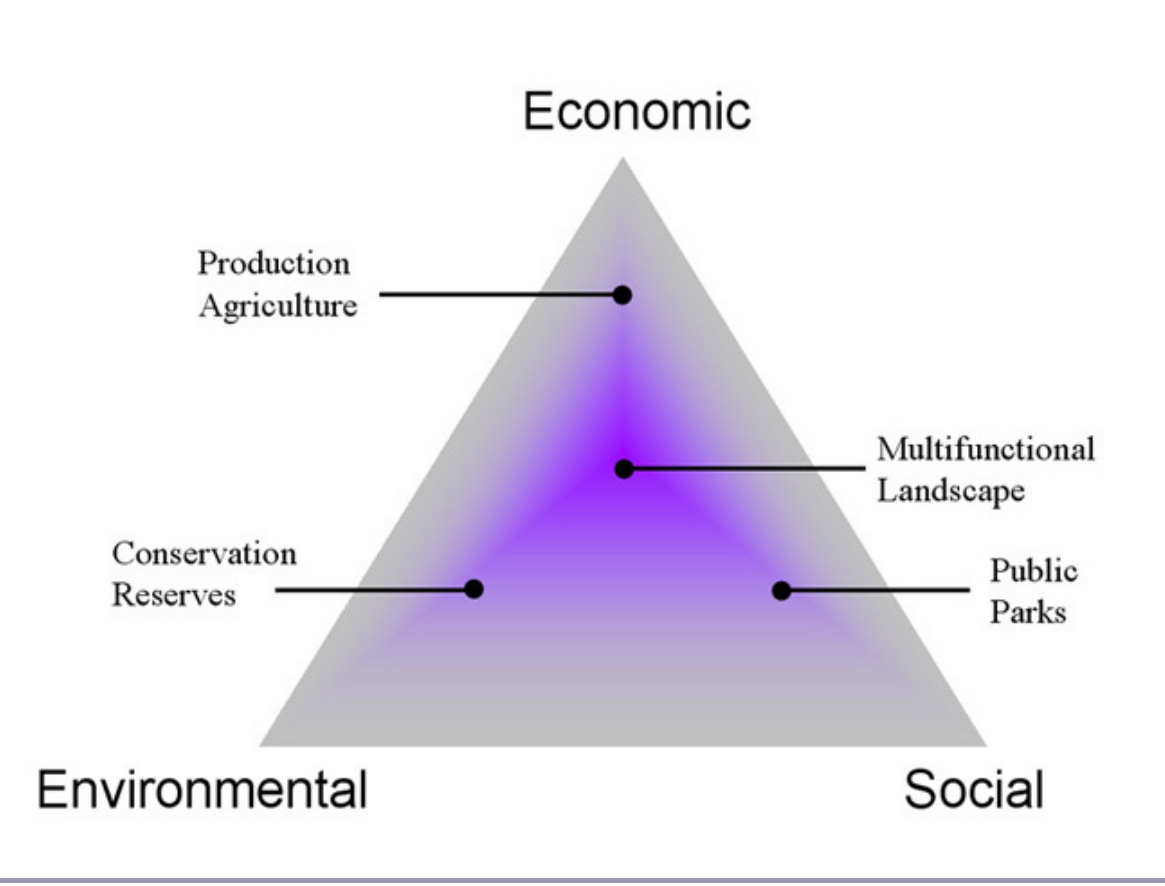
Figure 1. Conceptual diagram of multifunctional landscape framework with economic, environmental, and social